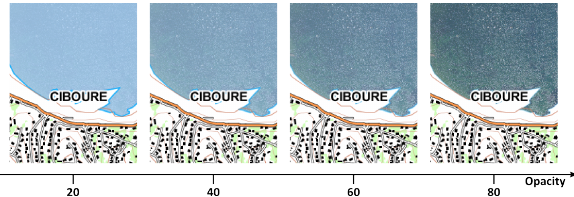
Figure 12: Opacity interpolation of overlaid vector data By procedural texturing The amount parameter of a procedu- ral texture is interpolated in order to make appear or disappear the rendered texture. Figure 13 shows a texture range where the amount is interpolated between a plain light green style and a Perlin noise texture style. Figure 13: Amount interpolation of a Perlin noise texture